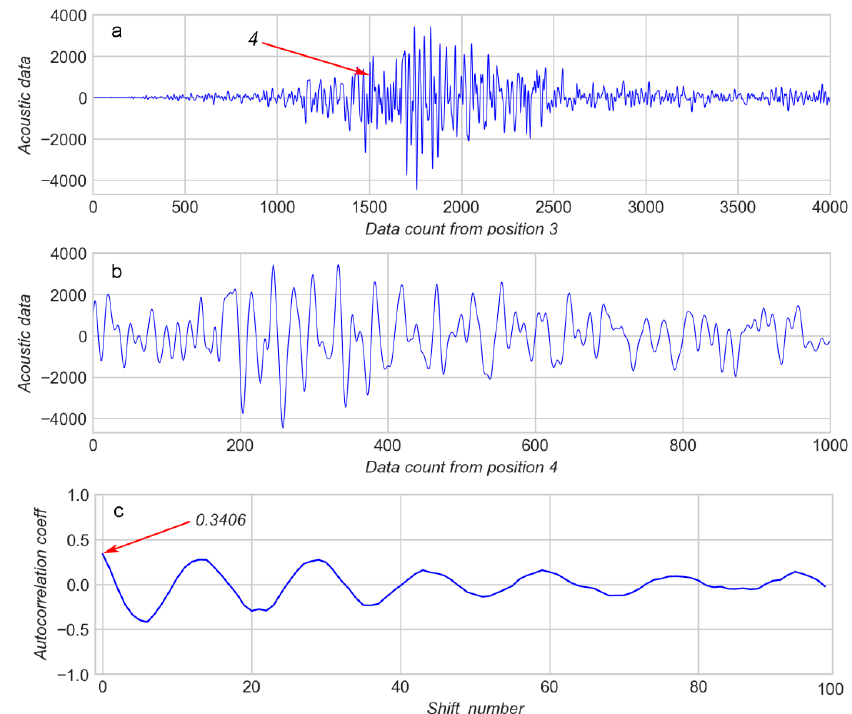
Figure 7. ( a ): “earthquake” event, see arrow 3 on Figure 1; ( b ): 1000 K window of acoustic data from arrow 4; ( c ): corresponding autocorrelation coefficients.